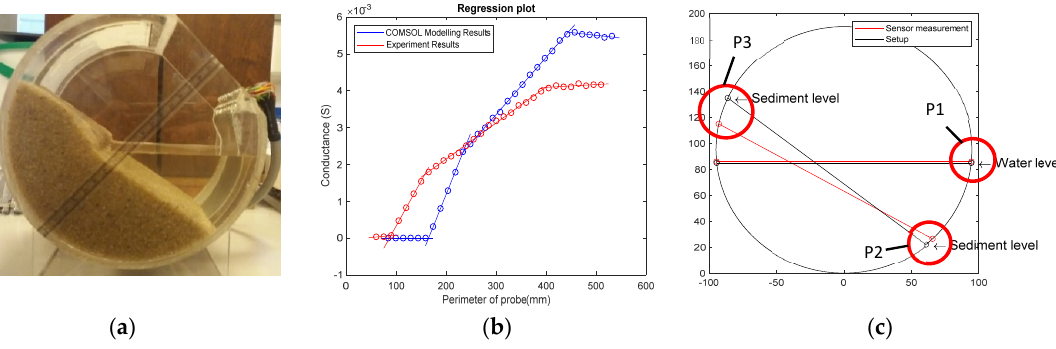
Figure 12. Sensor measured result of partially emergent sediment scenario: ( a ) experiment setup picture; ( b ) plot of sensor’s output conductance vs. probe length; ( c ) plot results of water and sediment surface.